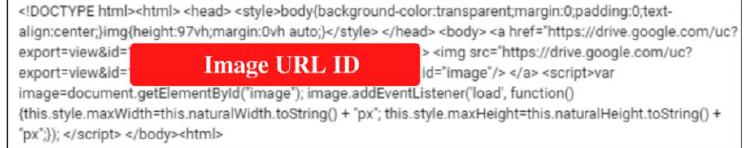
Figure 7. Dynamic image HTML embedded code.